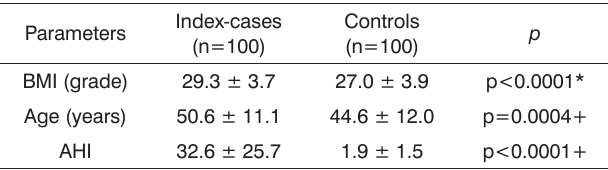
Table 2. Clinical and polysomnographic parameters of index cases compared to